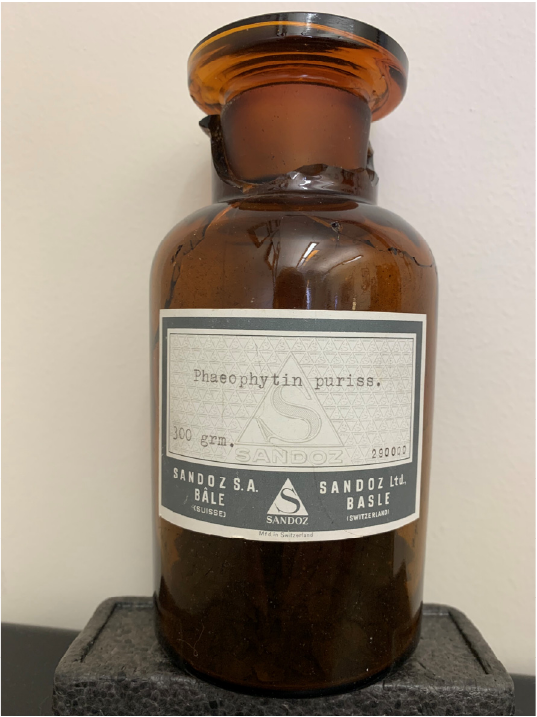
Figure 3. Gift bo tt le containing “Phaeophytin puriss. 300 grm.” (ca. 1961). Figure 3. Gift bottle containing “Phaeophytin puriss. 300 grm.” (ca.